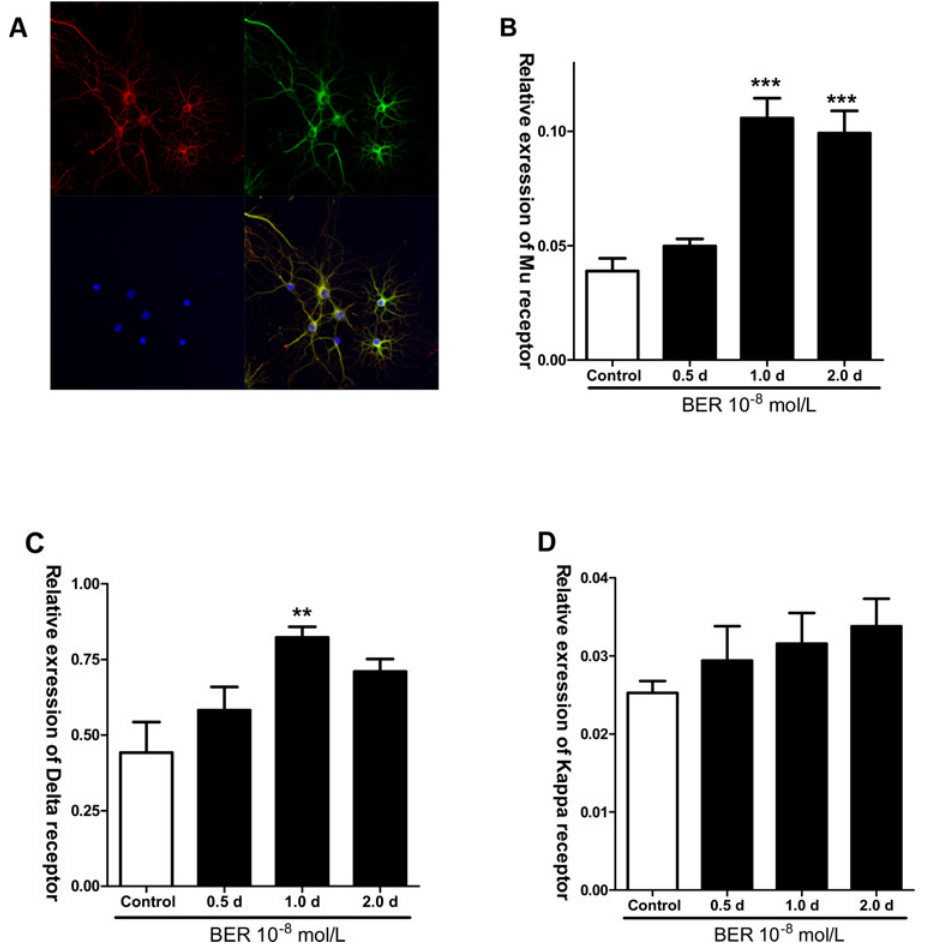
Fig 5. Effects of berberine (BER) on opioid receptors expression of mRNA level in rat fetal cortical neurons. A: Fetal cortical cells cultured for 7 days expressed MOR ( β -tubulin + in red, MOR + in green, DAPI + in blue and merged). B: Berberine (BER, 10 -8 mol/L) significantly increased MOR mRNA expression when added 1.0 and 2.0 day before cell collection in 7-day culture ( *** P < 0.001 compared with control). C: Berberine (BER 10 -8 mol/L) increased DOR mRNA expression when added1.0day before cell collection in 7-day culture. * P < 0.05 compared with control. D: Berberine had no effect on KOR expression in 7 day cortical neuron